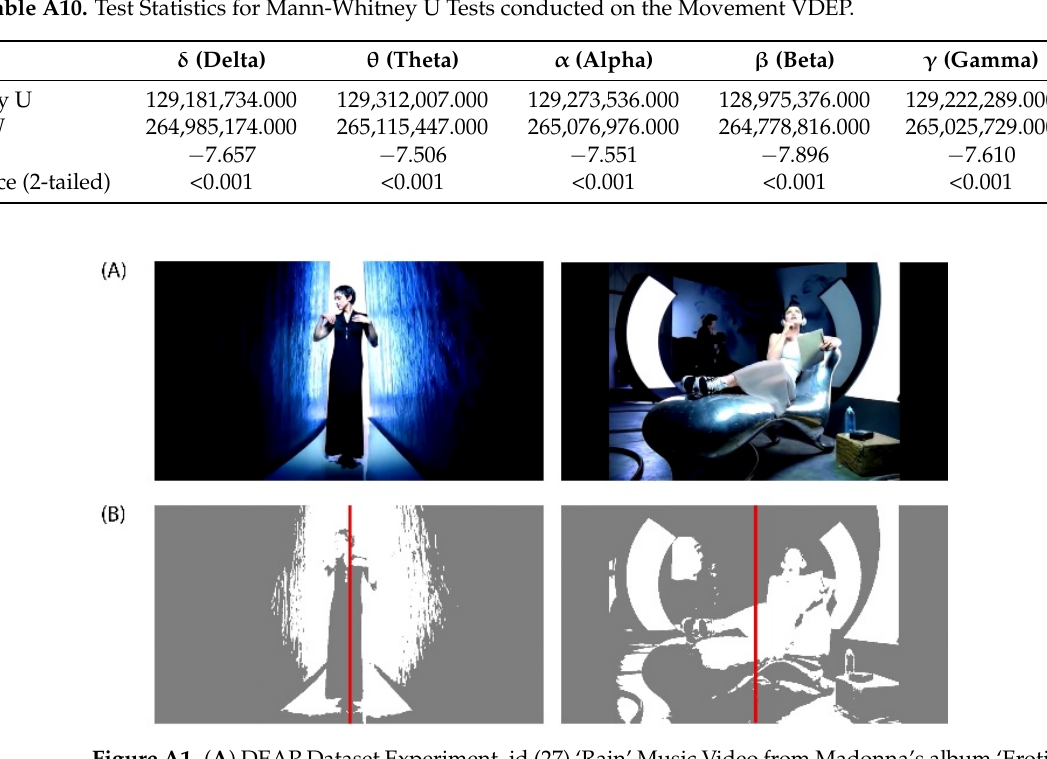
Figure A2. ( A ) DEAP Dataset Experiment_id (17) ‘All I Need’ Music Video from AIR’s album ‘Moon Safari’ released on Virgin Records in 1998. DEAP Dataset. Source YouTube Link: http://www.youtube.com/watch?v=kxWFyvTg6mc. ( B ) The upper music video frame shows a composition where a cold colour palette predominates while the lower music video frame reveals a warm colour